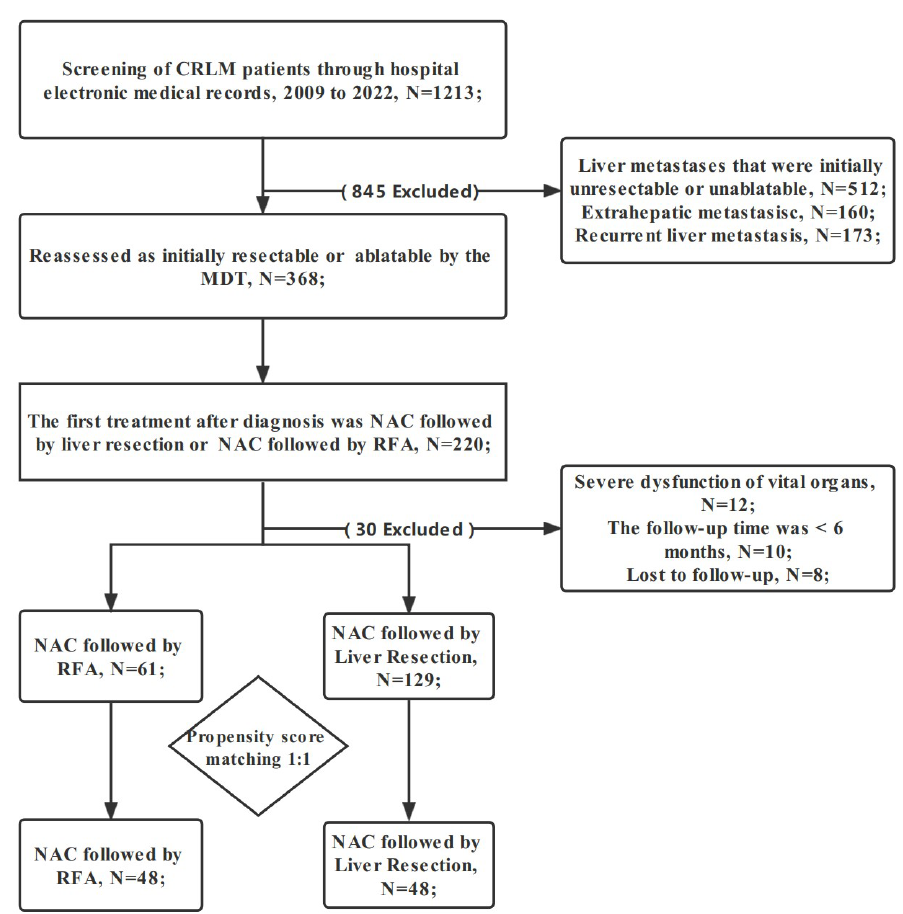
Figure 1. Flowchart of patient selection. CRLM: colorectal liver metastasis; RFA: radiofrequency ablation; NAC: neoadjuvant chemotherapy; MDT: multidisciplinary team. ablation; NAC: neoadjuvant chemotherapy; MDT: multidisciplinary